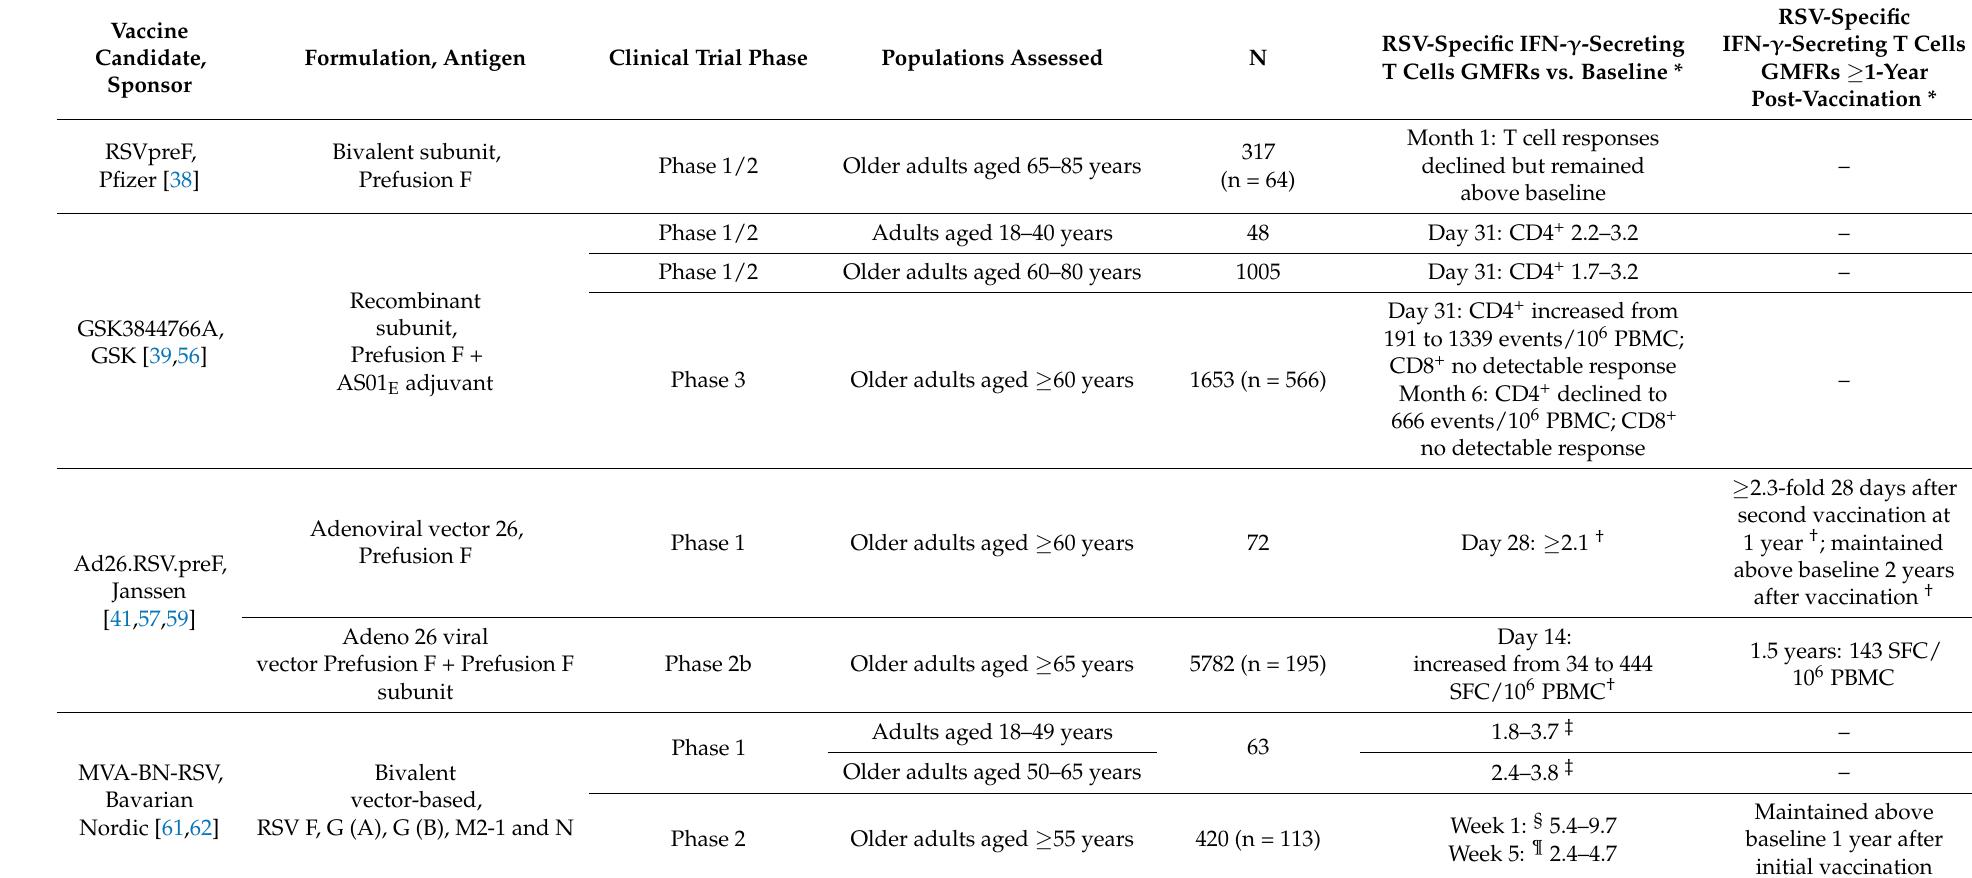
Table 2. Cellular immune responses to current Phase 3 RSV vaccine candidates in healthy and older adults in clinical